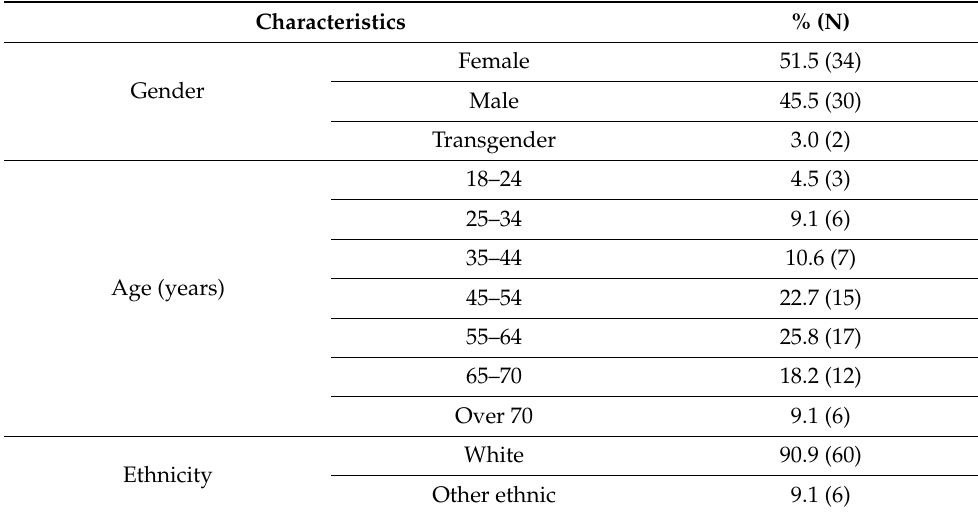
Table 4. Participant characteristics for sub-sample who provided a response to the optional free-text item (n =